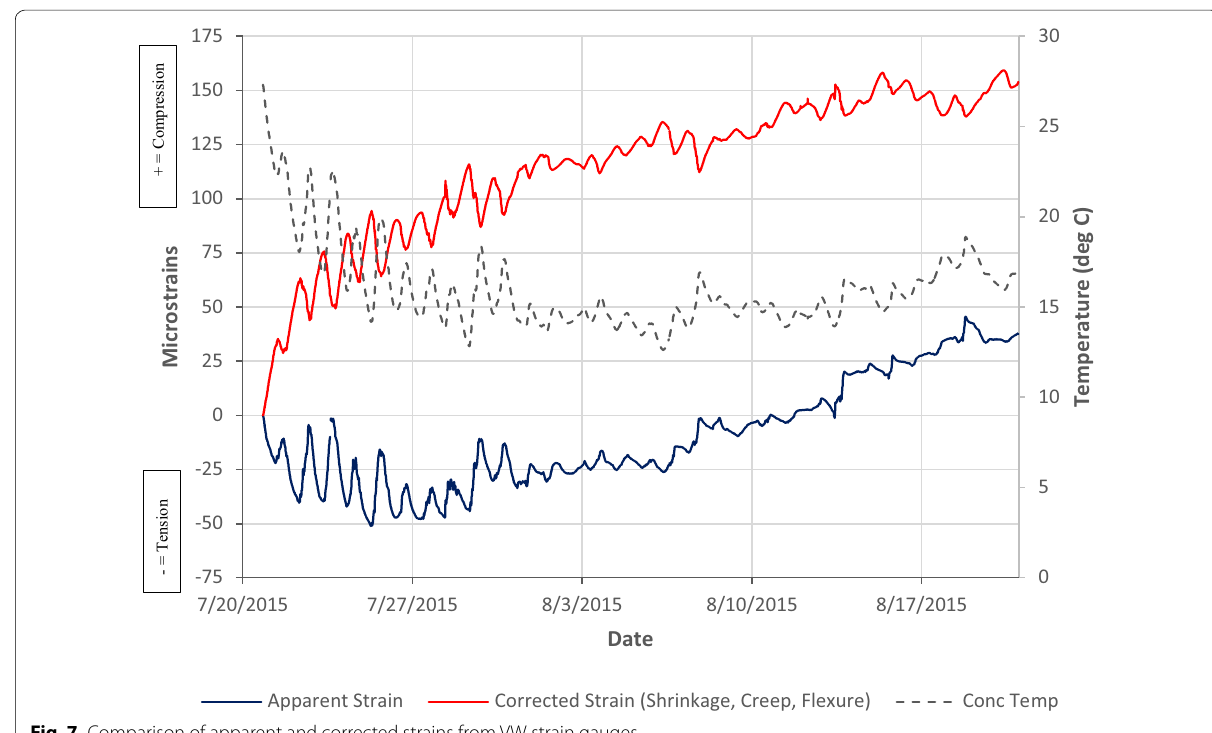
Fig. 7 Comparison of apparent and corrected strains from VW strain